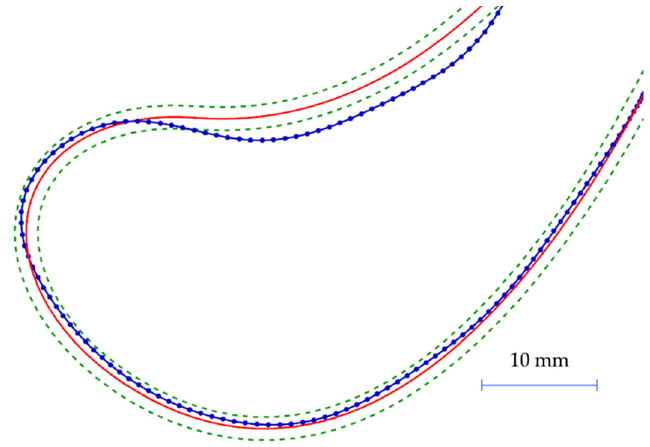
Figure 10. Serious discontinuities on a 999 points interpretation of overall airfoil section. Red straight line, ideal shape; green dashed line, tolerance zone; blue dot line, deformed unacceptable shape with error.